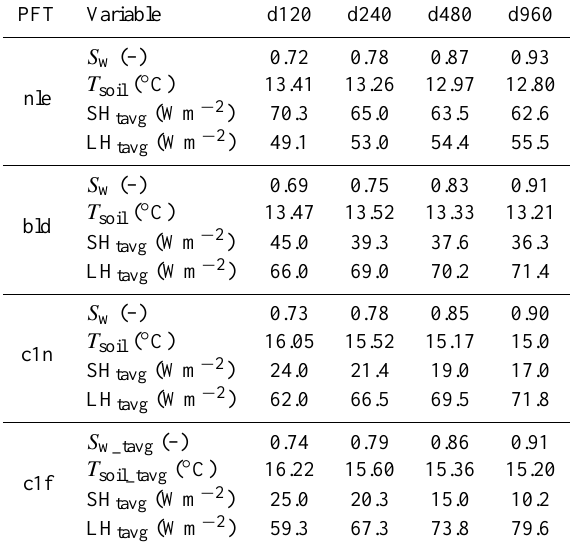
Figure 5. Scaling behavior of relative soil moisture ( S w ), soil tem- perature ( T soil ), sensible heat flux (SH) and latent heat flux (LH) for the four different canopy covers (nle, bld, c1n and c1f). The solid markers indicate the mean value of the distribution for each grid resolution.